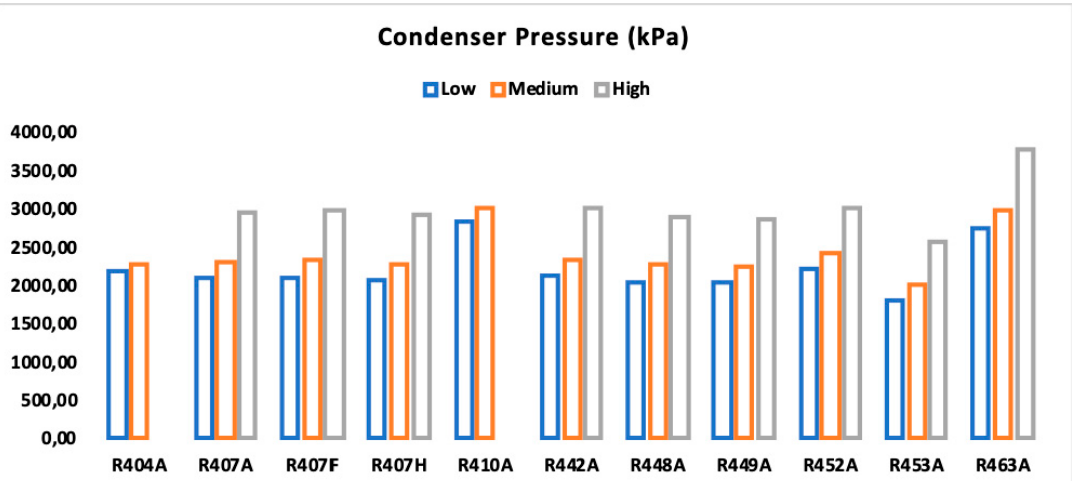
Figure 16. Condenser pressure of all refrigerants.